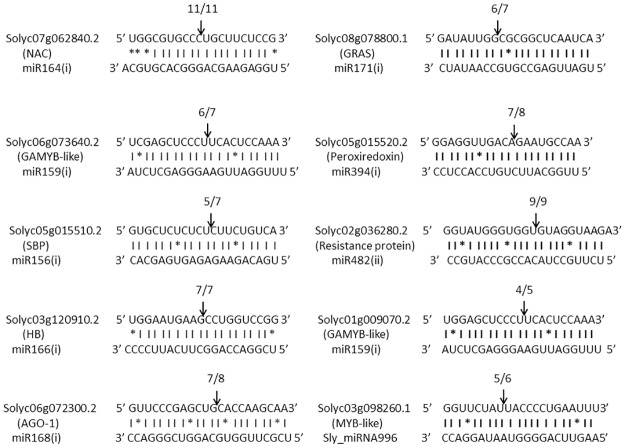
Mapping of amplified cDNA cleaved products obtained from 5’RLM-RACE.Using psRNAtarget Analysis server, conserved miRNAs including, miR164(i), miR171(i), miR159(i), miR394(i), miR156(i), miR482(ii), miR166(i), and miR168(i) were predicted to target genes including NAC, GRAS, GAMYB-like, Peroxiredoxin, SBP, Resistance protein, HB and AGO-1, respectively. A novel miRNA, Sly_miRNA996 was predicted to target MYB-like transcription factor gene. The cleaved products were amplified through 5’RLM-RACE, cloned in pGEMT vector and mapped. Cleavage sites are depicted with arrows and number of positive clones obtained out of total clones is mentioned above the arrows.